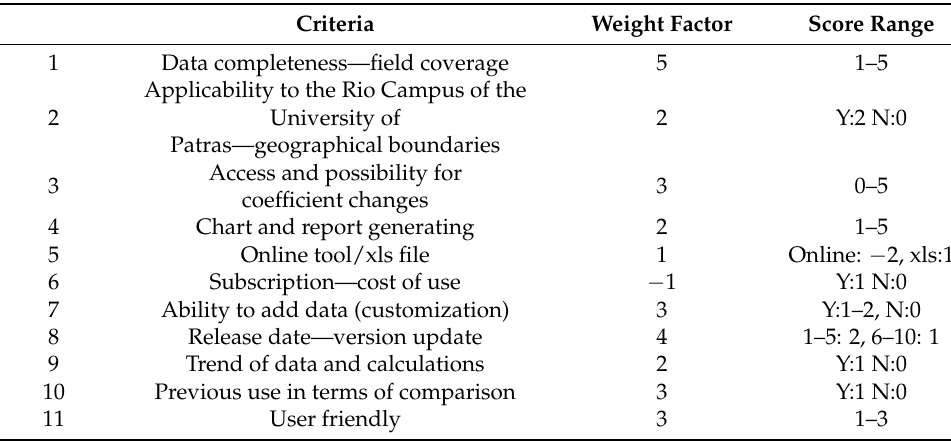
Table 2. Criteria for selecting the calculation